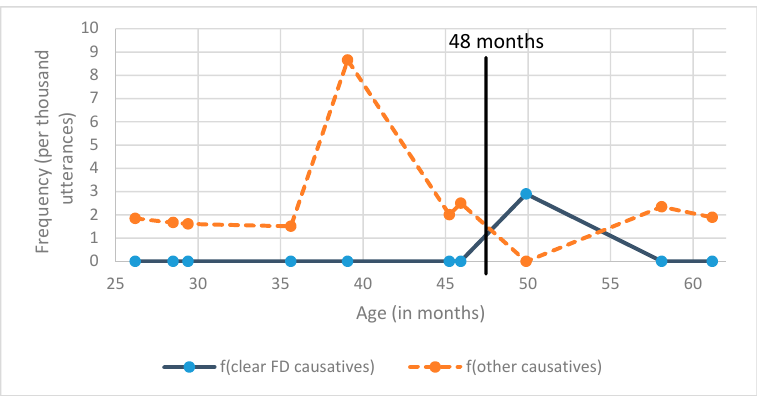
Figure 1. Frequency of Causatives by Age (Madeleine).